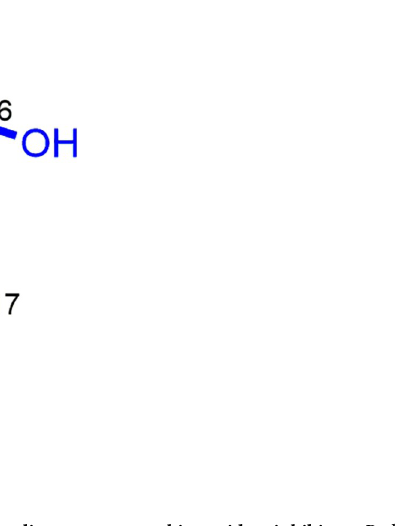
S1 Table. Percentage of inhibition of compounds 3 and 4 on human epithelial cell line. (DOC) S1 Video. The MD simulations for ligand 3 and XO protein. (MPEG) S2 Video. The MD simulations for ligand 4 and XO protein.